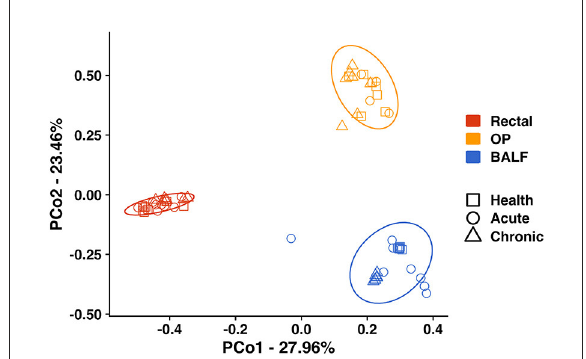
FIGURE2 Principal coordinate analysis including all sites—Principal coordinate analysis of Bray Curtis similarity index including all sites (Rectal—red; OP—orange; BALF—blue) in health (squares), in acute asthma (6 weeks) (circles) and chronic asthma (36 weeks) (triangles) after experimental asthma induction showed significant differences in microbial community structure between sites. The ellipses represent a 95% confidence interval. OP, oropharyngeal; BALF, bronchoalveolar lavage fluid.